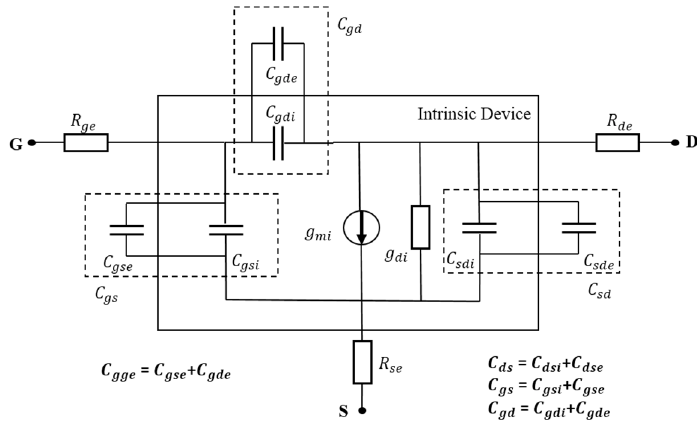
Figure 2. Small-signal equivalent circuit model.